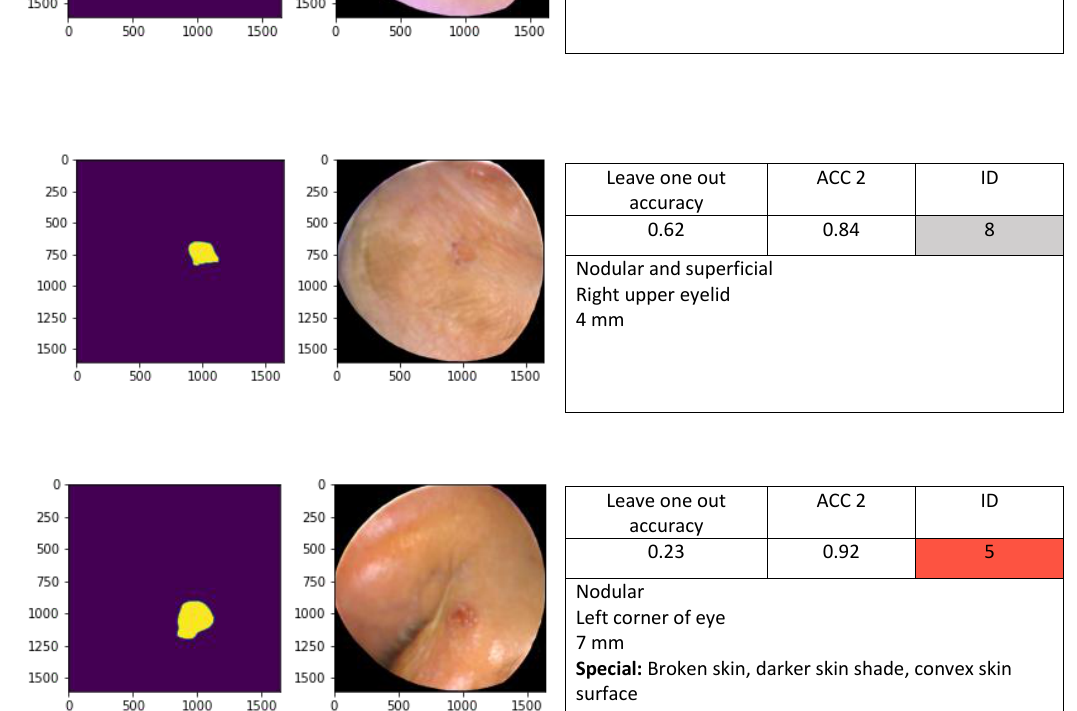
Special: Broken skin, darker skin shade, convex skin